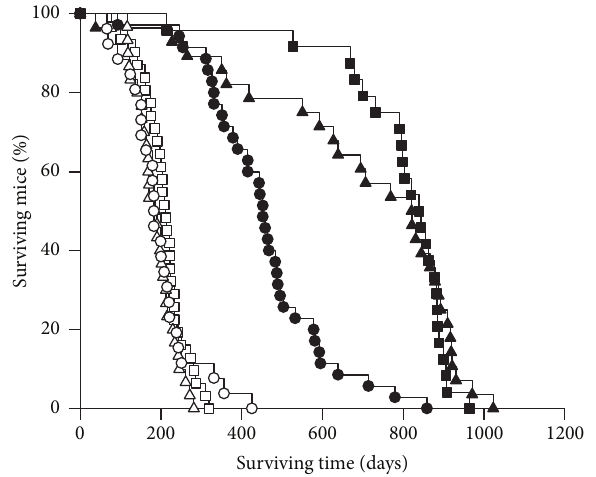
Figure 7: Survival of mice. Untreated pooled female and male Apc Min/+ and Apc +/+ mice of all three ob genotypes were kept under regular observation until euthanized. Survival of each genotype of mice was depicted as decreasing % of surviving mice compared with the number of mice present at the start of the experiment ( 𝑛 = 26 , 30 and 31 for groups of Apc Min/+ X Lep ob/ob ( I ), Apc Min/+ X Lep ob/wt ( 󳵻 ) and Apc Min/+ X Lep wt/wt ( ◻ ) mice, respectively, and 𝑛 = 35 , 28 and 24 for Apc +/+ X Lep ob/ob ( e ), Apc +/+ X Lep ob/wt ( 󳵳 ) and Apc +/+ X Lep wt/wt ( ◼ ) mice,